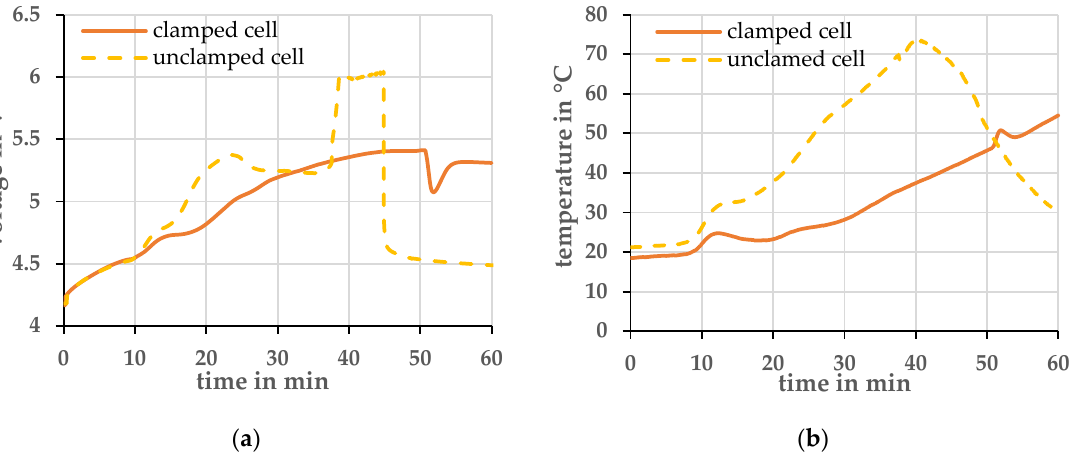
Figure 1. Comparison of a clamped and unclamped cell at a charging current of 1 C and an ambient temperature of 20 ± 2 °C. ( a ) Voltage profile; ( b ) Temperature profile.